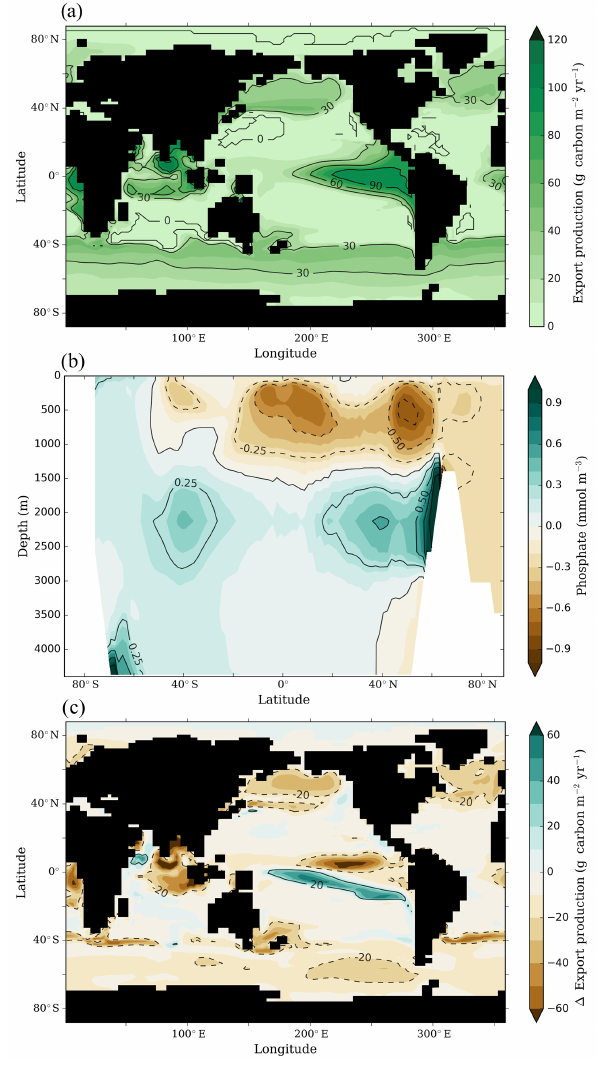
Figure 5. Changes in the export production of particulate organic matter (POC) and Phosphate concentrations between the O-LGM and O-PI experiments. (a) Annually averaged export of POC from the upper 50m (gCm − 2 year − 1 ) for O-PI, (b) the O-LGM − O-PI difference in Phosphate concentrations (mmolm − 3 ) and (c) the O- LGM − O-PI difference in export production of POC from the upper 50m (gCm − 2 year − 1 ).